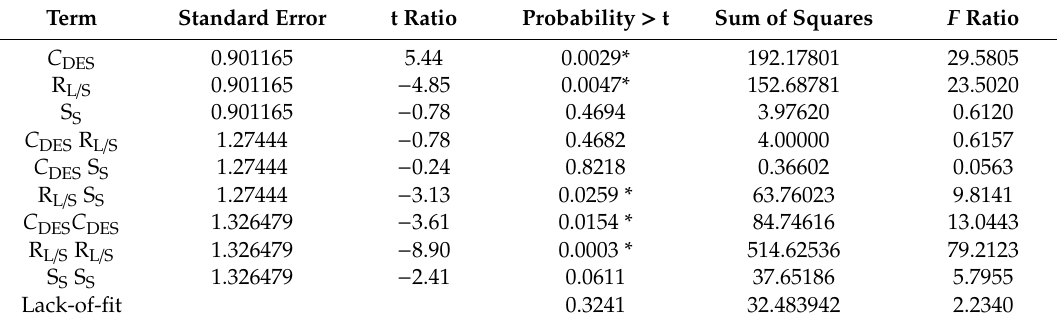
Statistical information on the model constructed on the basis of Box–Behnken experimental